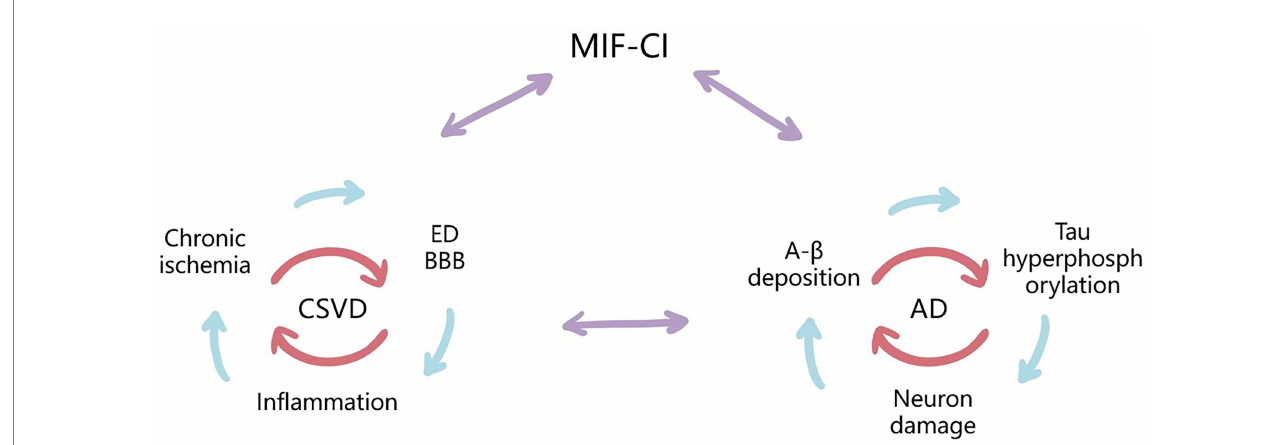
FIGURE 2 Possible mechanisms for the Upregulating Role of MIF and Synergism Between CSVD-CI and AD-CI. MIF may cause cognitive impairment through both vascular risk factors and neurodegenerative lesions. CSVD is a small ischemic or bleeding lesion caused by pathological small vessels or brain degeneration, including chronic cerebral ischemia and hypoperfusion, ED and BBB destruction, inflammatory response, and other pathogenesis, which are interrelated with the pathologies of AD, and MIF may be involved in the above mechanisms. They all cause neuronal and cognitive impairment by initiating a cascade of inflammatory